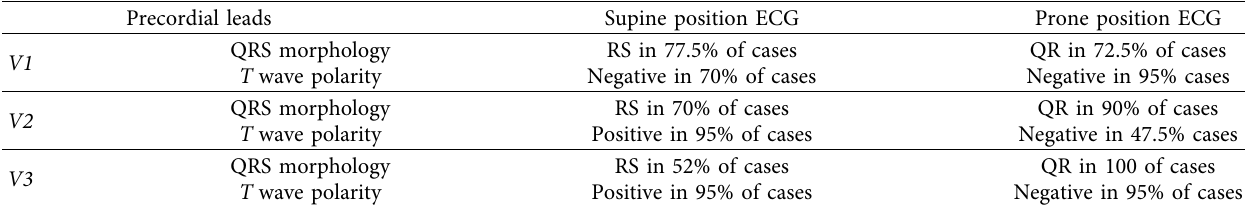
Table 3: Effect of prone position on QRS morphology and T wave polarity in precordial